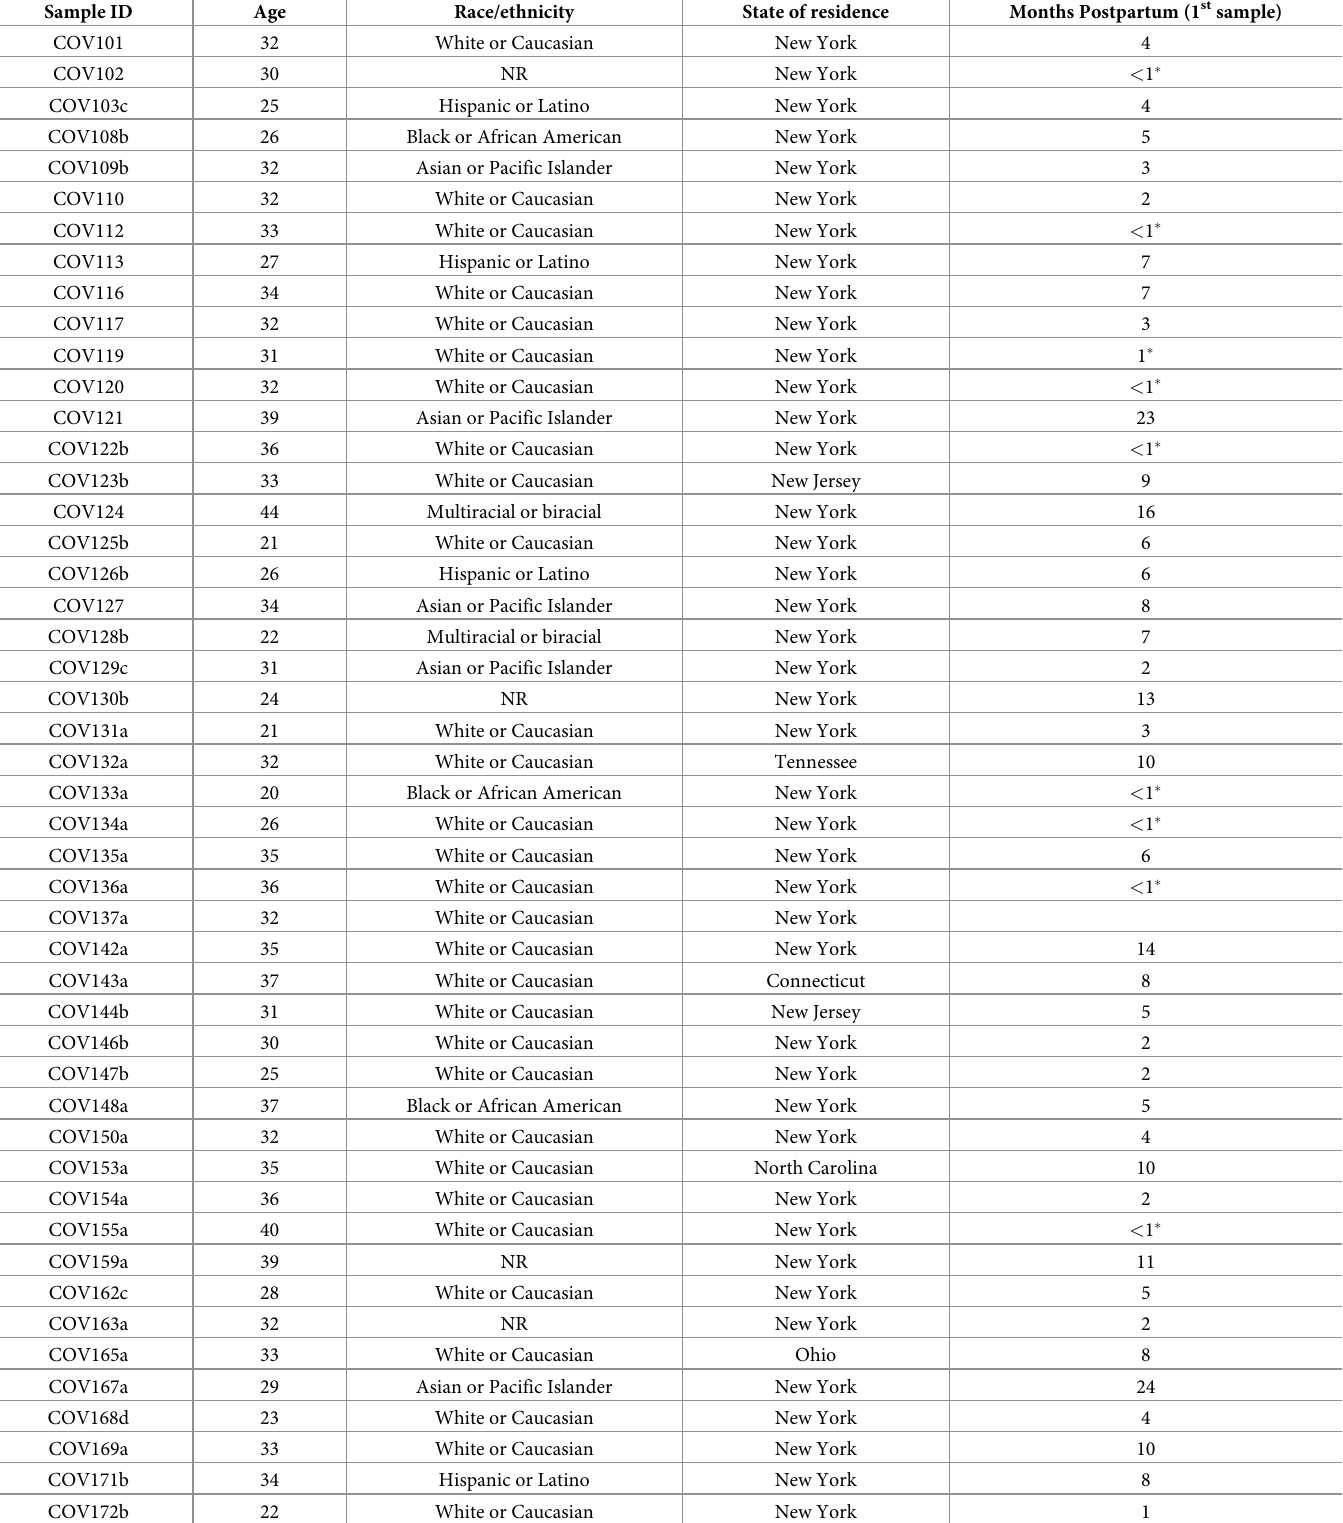
Table 1. Participant